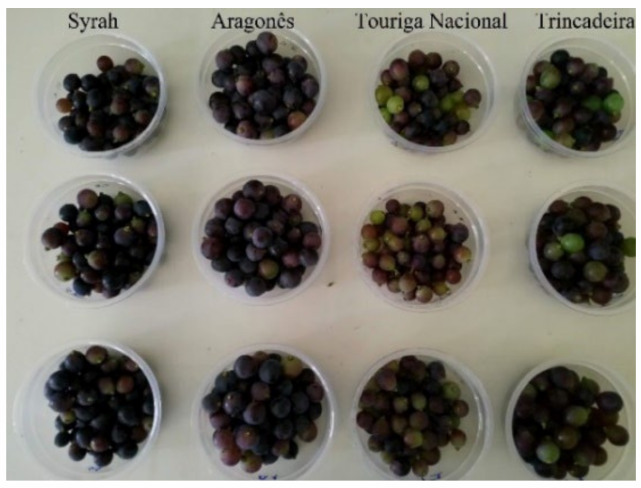
Figure 2. Berries collected at the beginning of v é rasion in